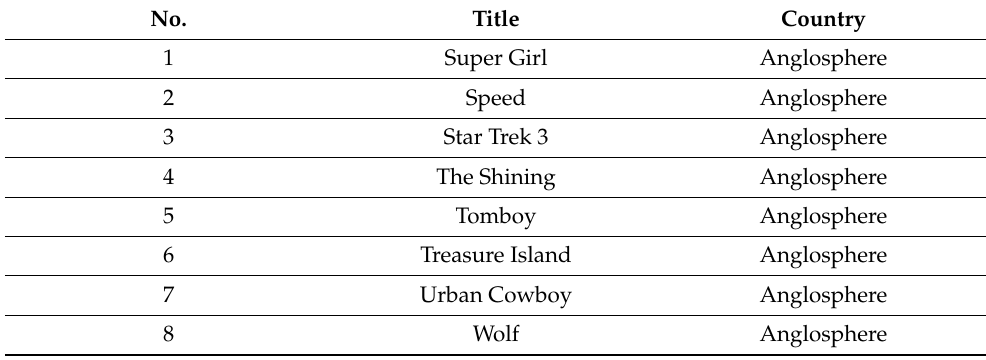
Table 3. Results of production country tag generation via voice file. No.